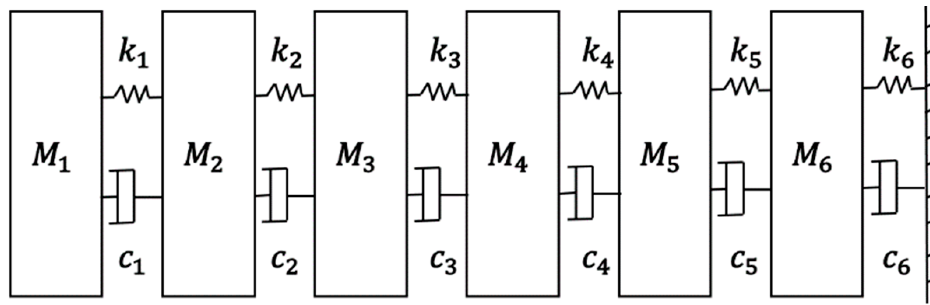
Figure 1. Six-DOF chain model of a cantilever beam.